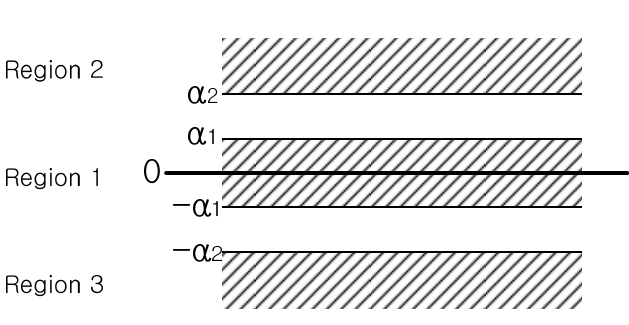
Figure 5. The region classification.